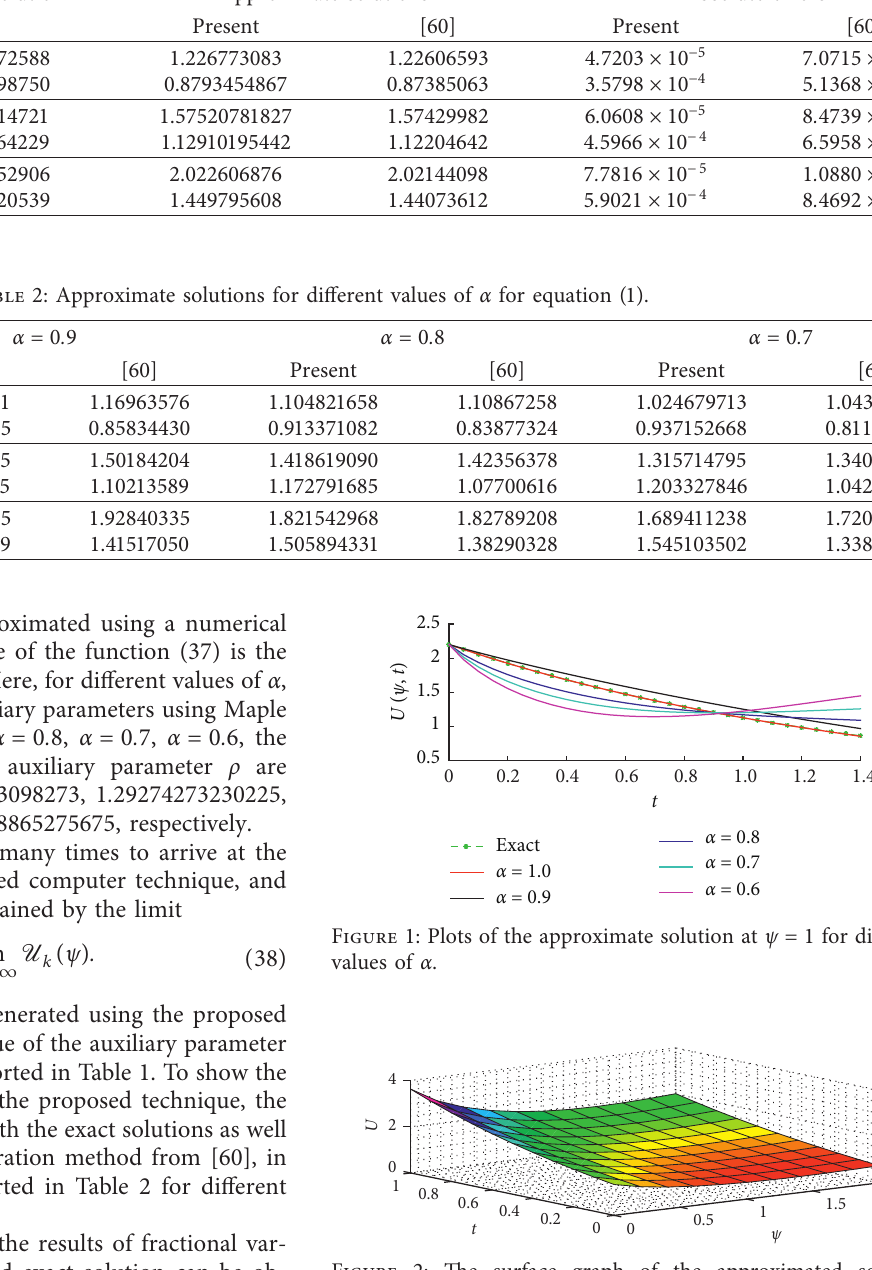
Figure 2: The surface graph of the approximated solution ( ψ , t, ρ ) for α � 0 . U 3